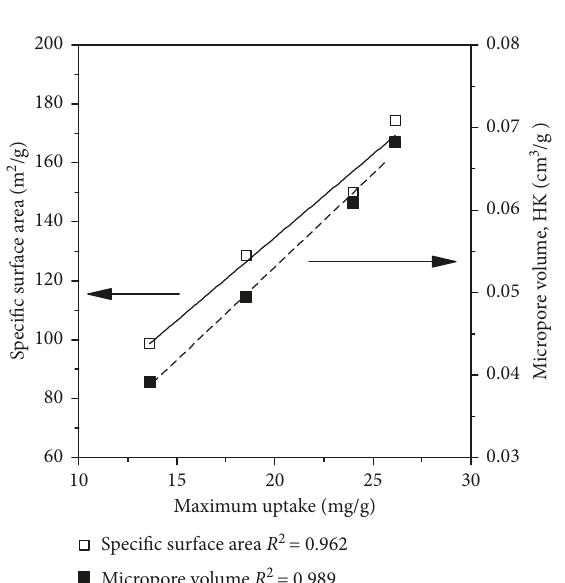
Figure 8: Maximum adsorption capacity (D-A model) related to BET specific surface area and micropore volume.